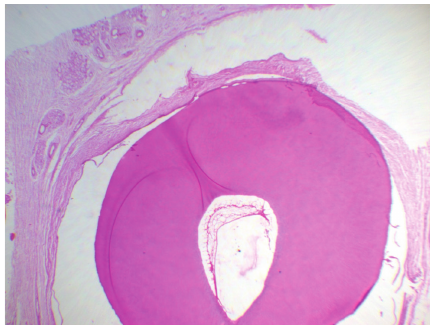
Figure 6: Histological section showing pulp space and fibrous connective tissue with minor salivary glands (objective